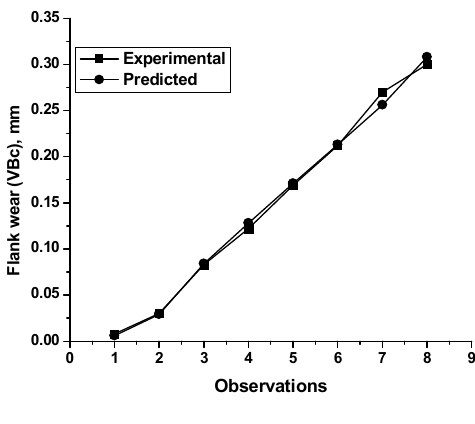
Fig.4. Experimental vs. predicted values of flank